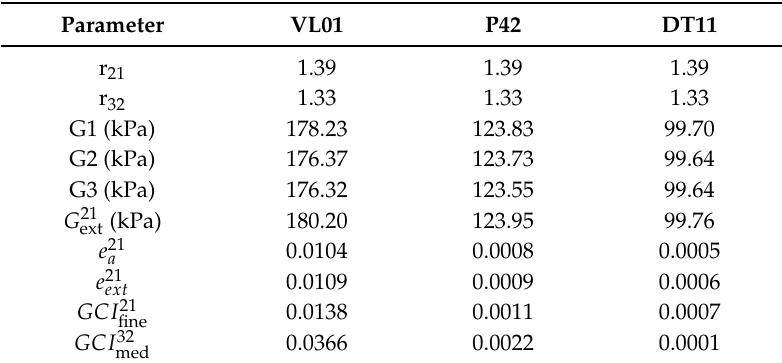
Table 4. Discretization error and uncertainties in numerical solutions [4].